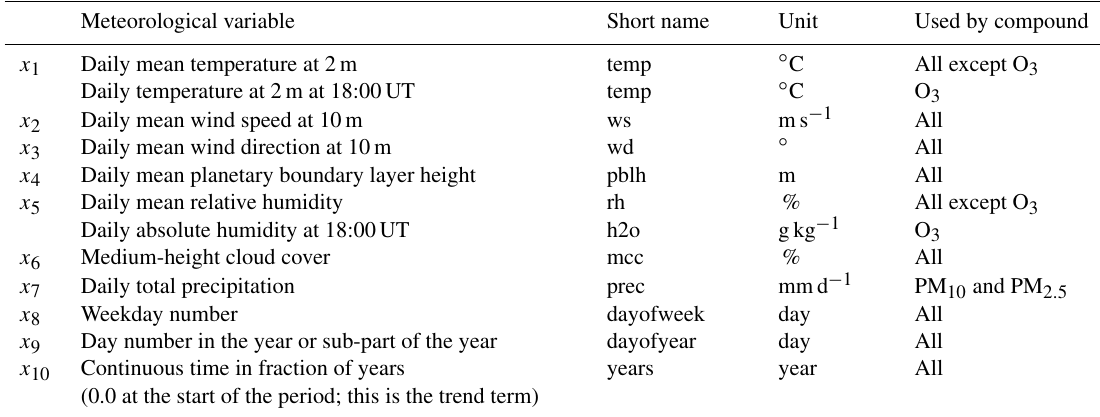
Table 1. List of meteorological and time variables used in the AirGAM model (Eq. 1) for various compounds. The short names refer to those used in the text and graphics files in Sect. S5 in the